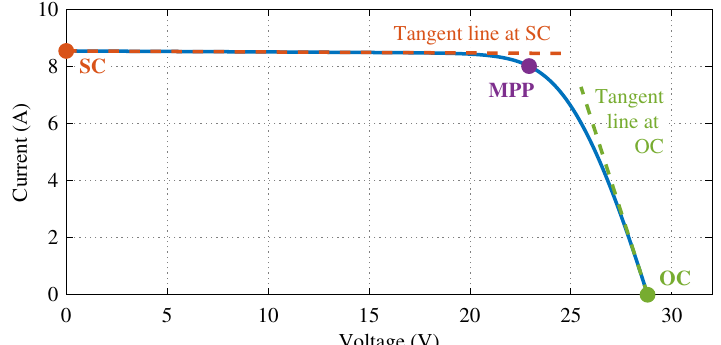
Figure 2. Typical I-V characteristic curve of a PV module in the first